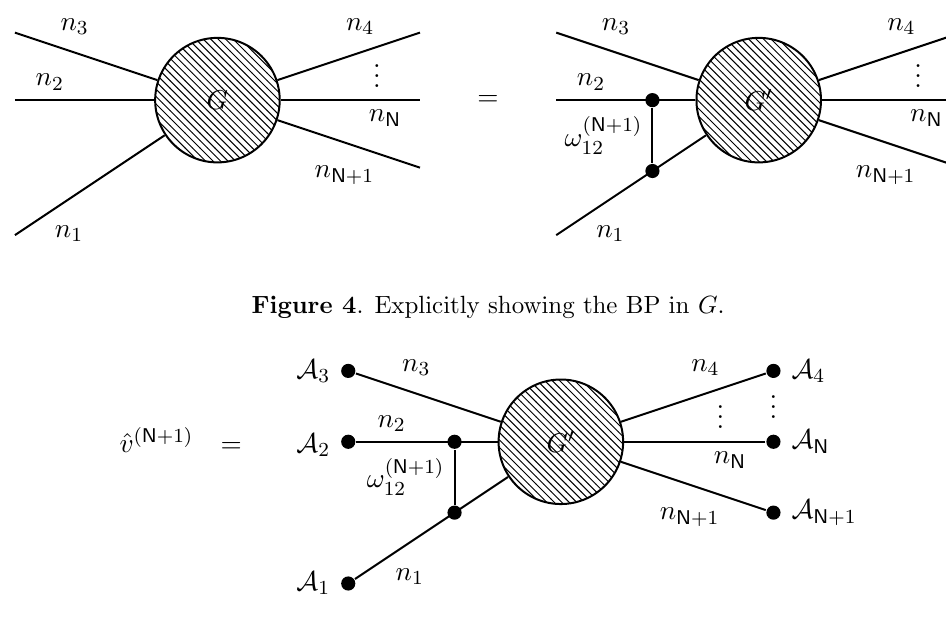
Figure 5 . The graph of ^ v ( N +1) with edge representing the BP ^ g f 12 g explicitly shown.